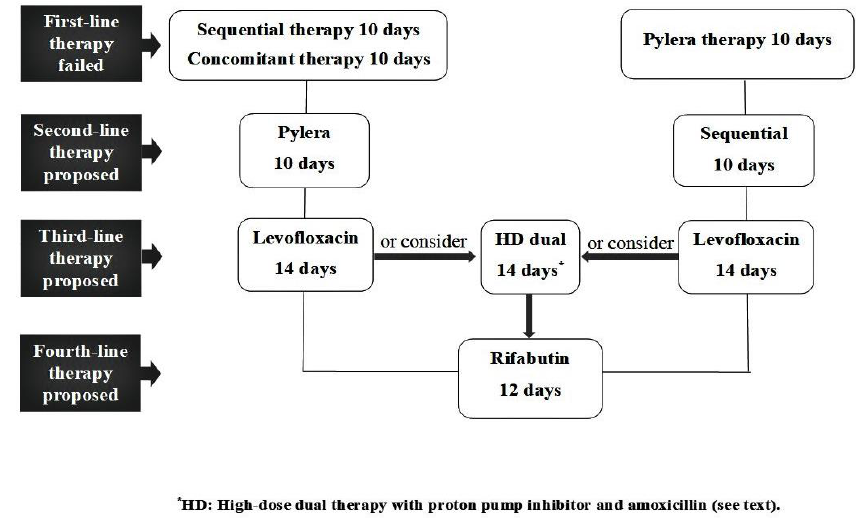
Figure 2. The proposed therapies sequence.